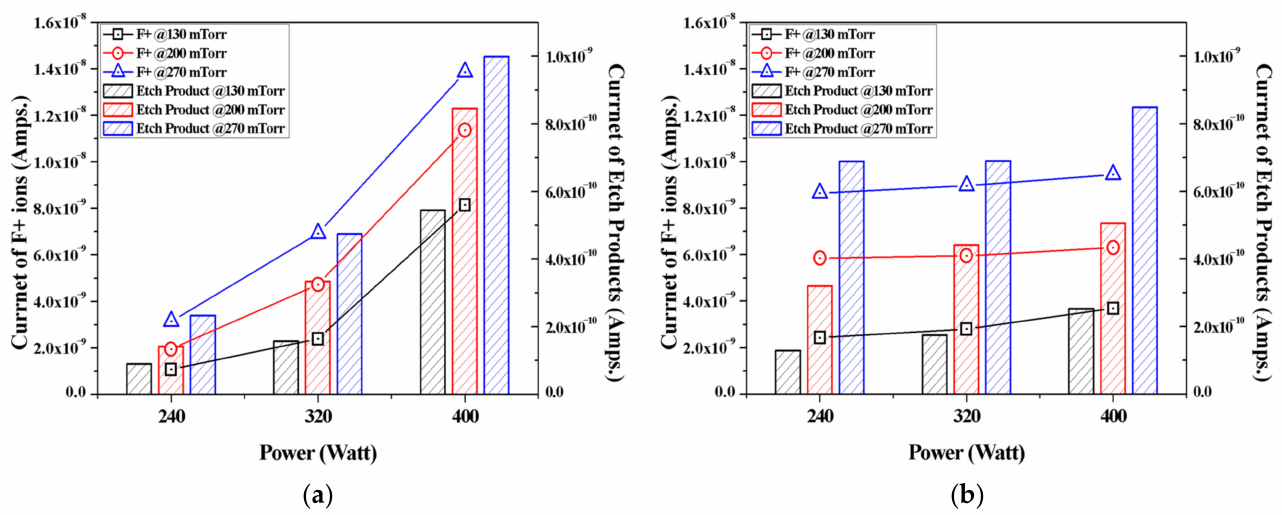
Figure 3. ( a ) Intensity of F+ ions and the sum of the etch product ions (SiF+, SiF 2 +, and SiF 3 +) during NF 3 plasma silicon oxide etching as functions of the input power for various working pressures; ( b ) Intensity of F+ ions and the sum of the etch product ions (SiF+, SiF 2 +, and SiF 3 +) during F 3 NO plasma silicon oxide etching as functions of the input power for various working